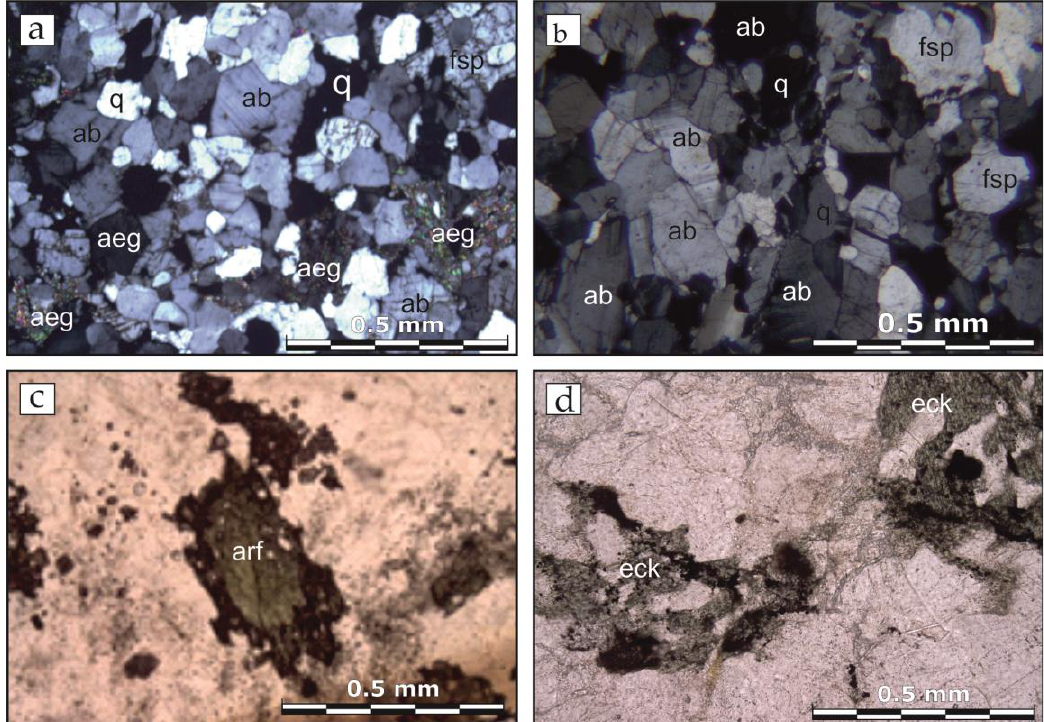
Figure 7. Petrography of quartz albitites. ( a ) Fine-grained, ( b ) medium-grained. Crossed nicols. ( c ) Arfvedsonite fringed by chevkinite in albitite. Parallel nicols. ( d ) Ferro-eckermannite clusters with nests of REE minerals in albitite. Parallel nicols. q — quartz, ab — albite, aeg — aegirine, arf — arfved- sonite, fsp — K-feldspar, eck — ferro-eckermannite. The granites and the host rocks are intensely broken down and fenitized along the contact. The main ore body is composed of thin-banded rocks of a quartz – feldspathic com- position, among which there occurs veins and veinlets of quartz and fine-grained quartz albitites. In quartz veins, ore minerals are confined to clusters of amphibole of the arfved- sonite series, whereas in albitites they fringe and cut such amphiboles. In thin-banded ores, the alkaline amphiboles and ore mineralization are localized along foliation. Along thin fractures in the rocks, veinlets of hematite, fluorite, carbonate, and, less often, chlorite